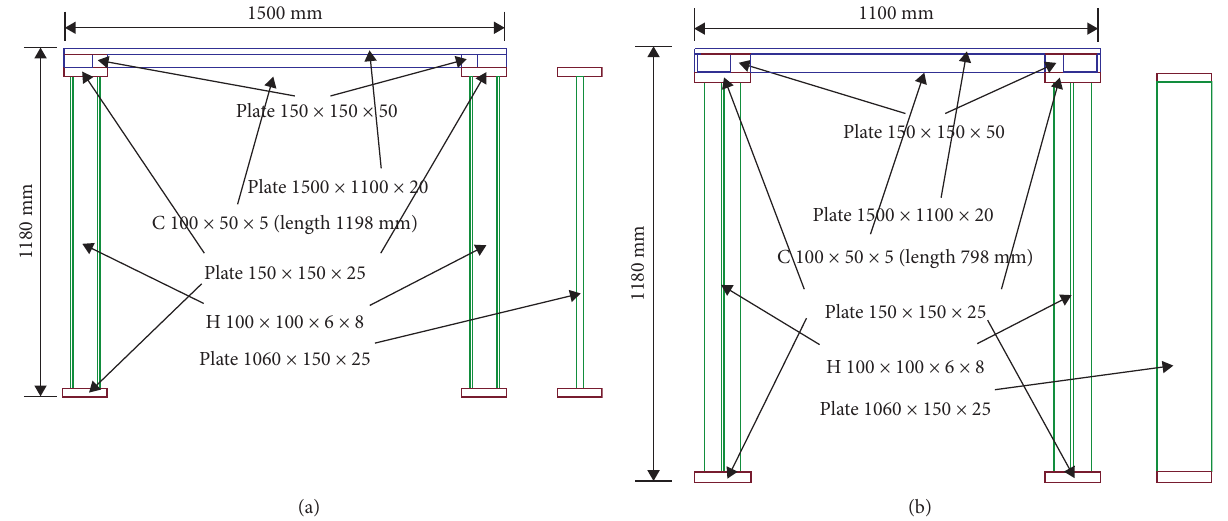
Figure 26: A single floor of the eight-story steel frame: (a) front view and (b) side